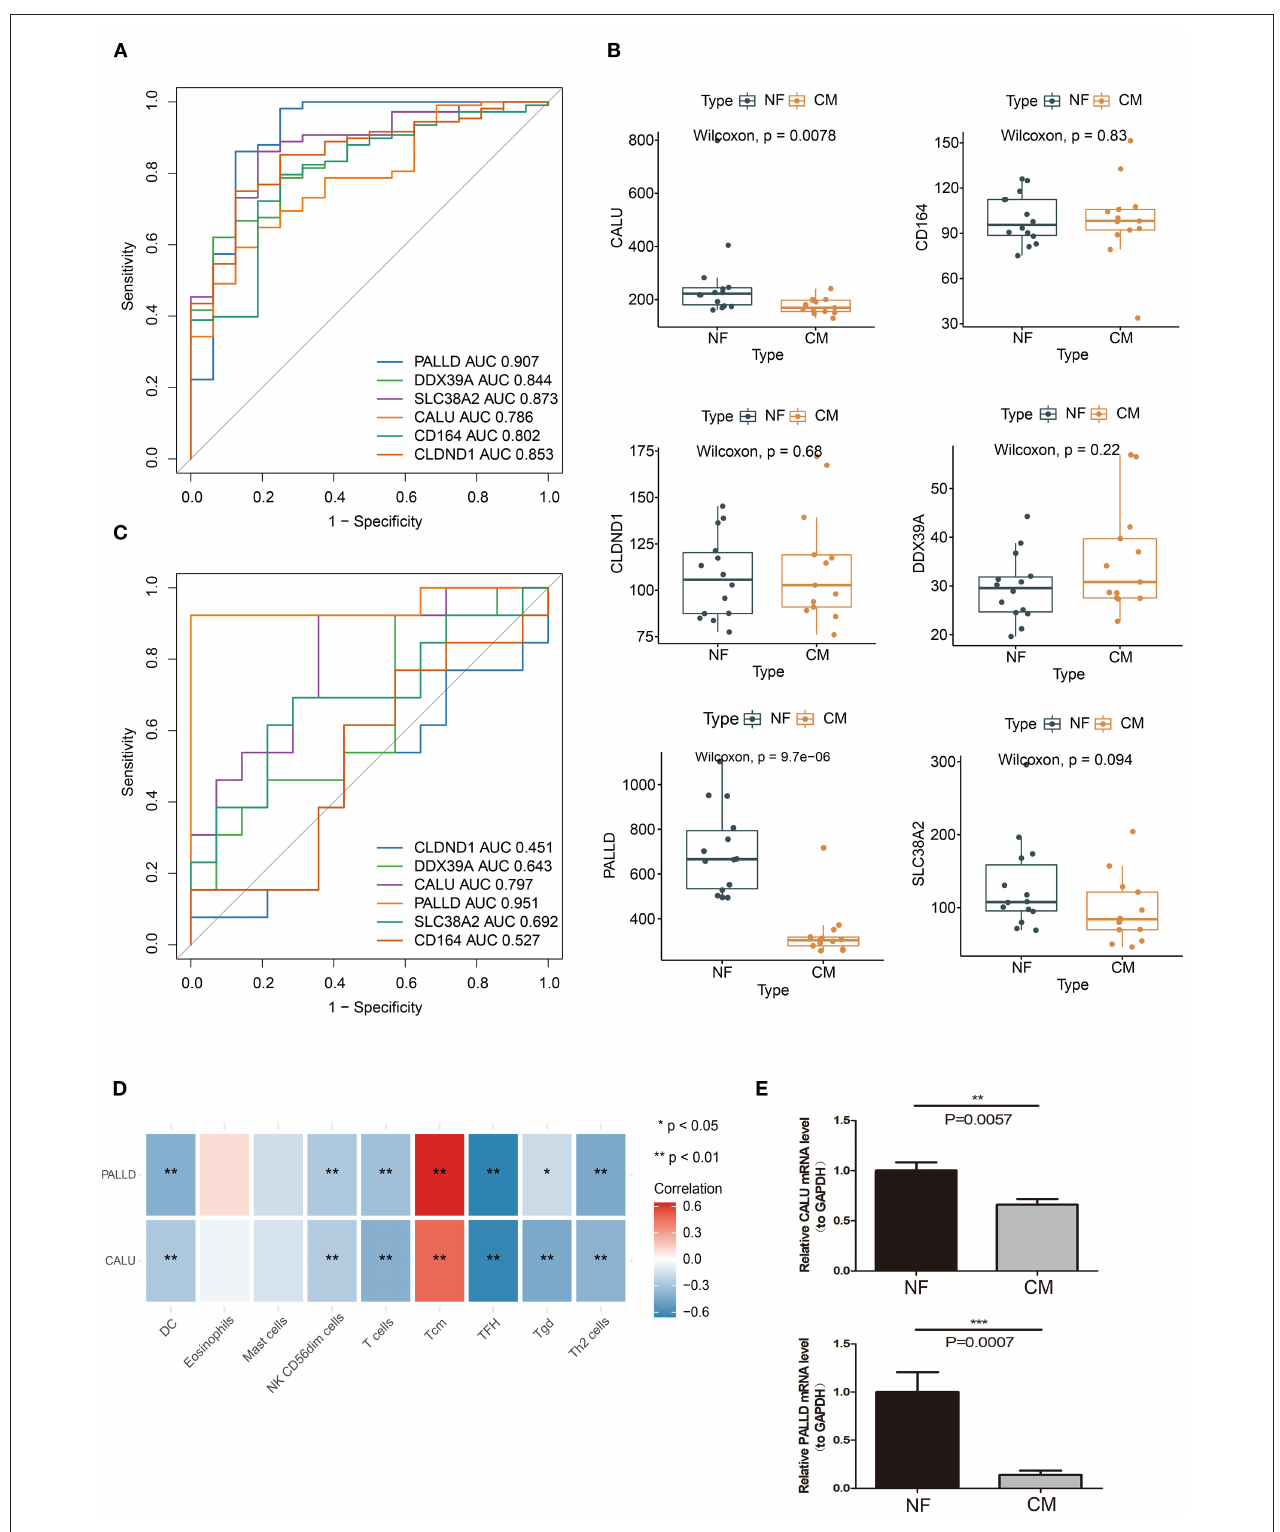
FIGURE 6 | Verification of biomarkers for CM. (A) ROC curve evaluation of the diagnostic effectiveness of candidate biomarkers using GSE5406 dataset. (B) The expressions of candidate diagnostic biomarkers in the GSE116250 dataset. (C) ROC curve evaluation of the diagnostic effectiveness of candidate biomarkers using GSE116250 dataset. (D) Heatmap of correlations between PALLD, CALU and differentially infiltrated immune cells. (E) Real-time PCR analyses of the expression levels of PALLD and CALU in PBMCs isolated from CM and NF patients * p < 0.05, ** p < 0.01, *** p < 0.001